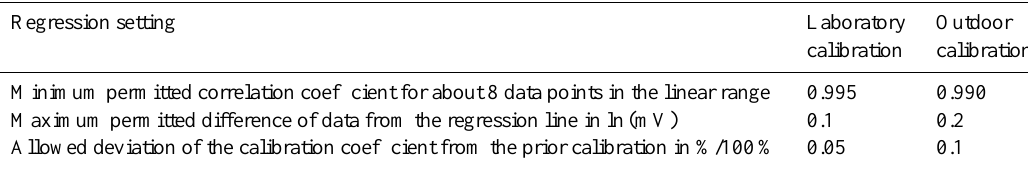
Table 1. Regression settings.